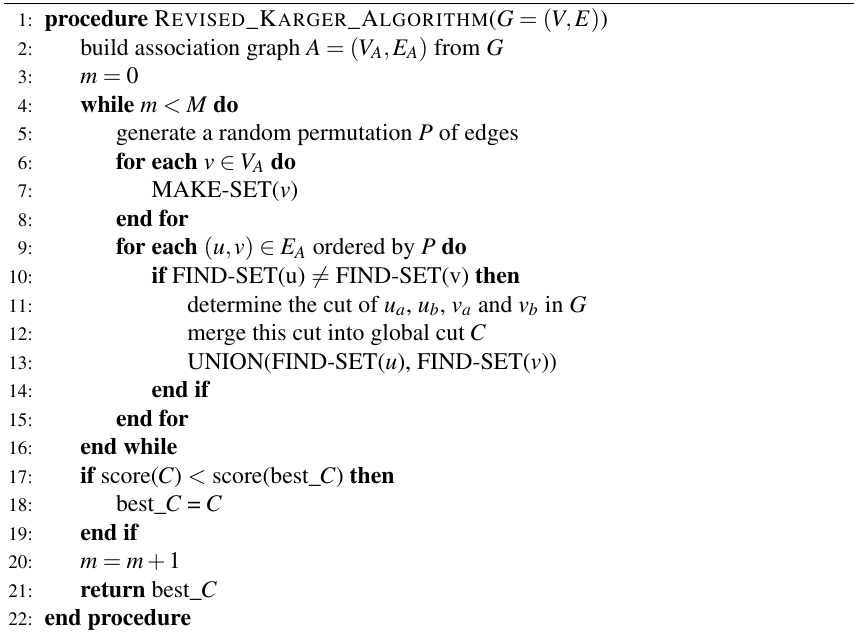
Algorithm 1 Revised Karger’s algorithm for Minimum Multiple s-t Cut